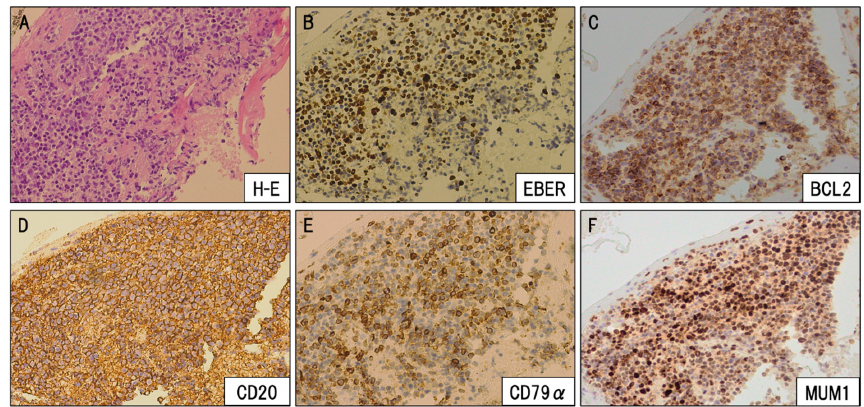
Figure 4. The pathologic examination of the choroid plexus region showed di ff use proliferation of large-sized lymphoid cells. ( A ) H-E staining, ( B ) Epstein–Barr virus (EBER), ( C ) BCL2, ( D ) CD20, ( E ) CD79 α , ( F ) MUM1 ( × 10).